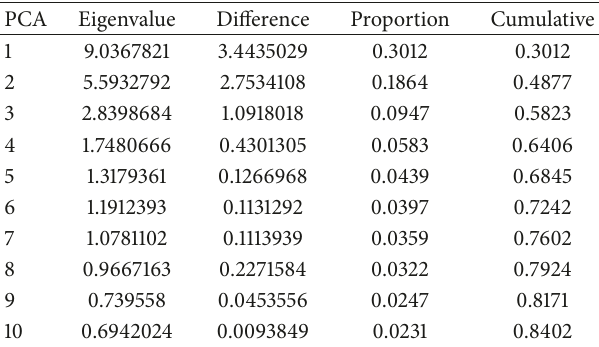
Table 5: Eigenvalues of the correlation matrix of principal compo- nent analysis of ninety-one fresh-market tomato